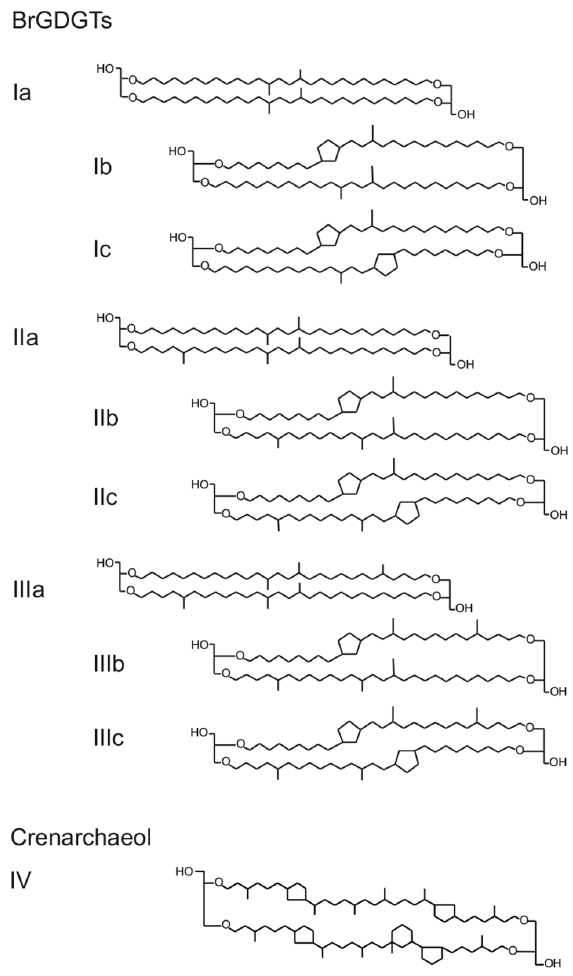
Figure 1. Chemical structure of brGDGTs (Ia-c, IIa-c, and IIIa-c) and crenarchaeol